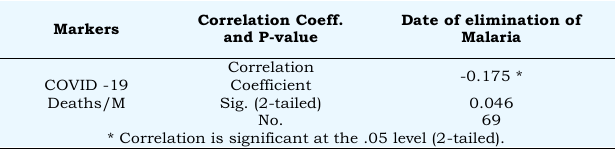
Markers Correlation Coeff. and P-value